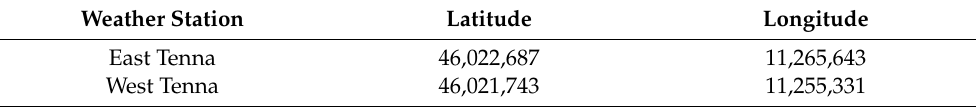
Table 3. Coordinates of Tenna’s weather